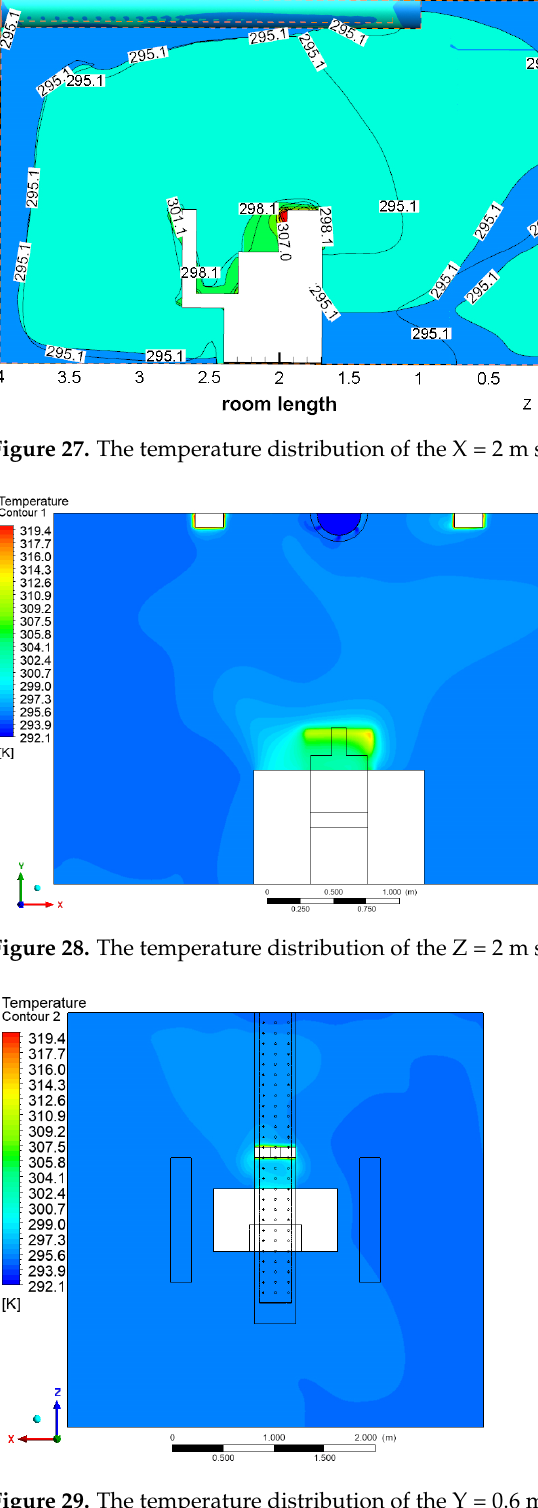
Figure 29. The temperature distribution of the Y = 0.6 m section.